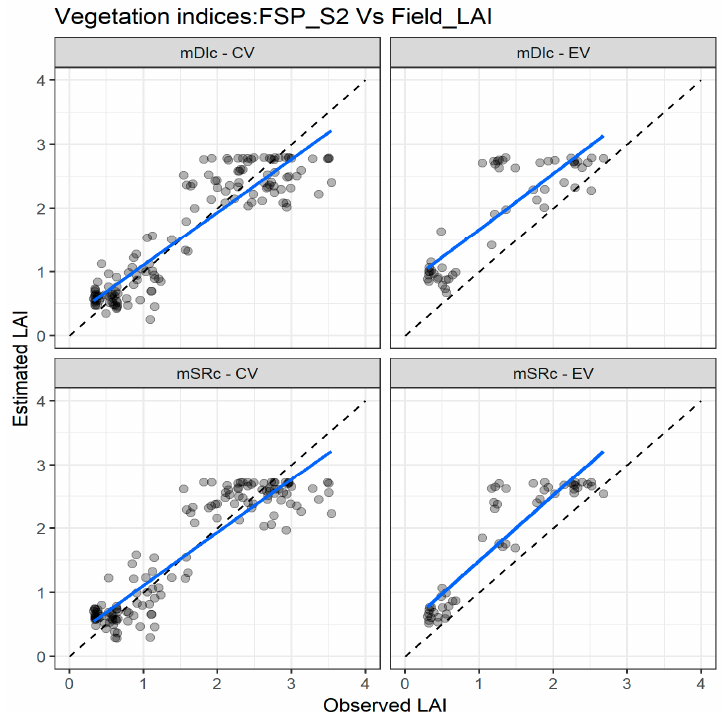
Figure 7. Comparisons of the measured and estimated LAI with the two best performing spectral vegetation indices using the FSP_S2 dataset for both cross validation (CV) and external validation (EV) datasets. mSR—modified simple ratio; mDI—modified difference index. The full line depicts the linear regression and the dashed line the linear regression through the origin.